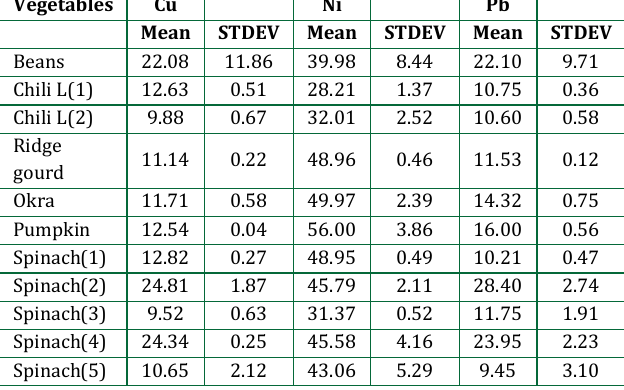
Table 5 (a): Average Concentration of Metals mg -kg in Soil samples of Vegetables from four sites.